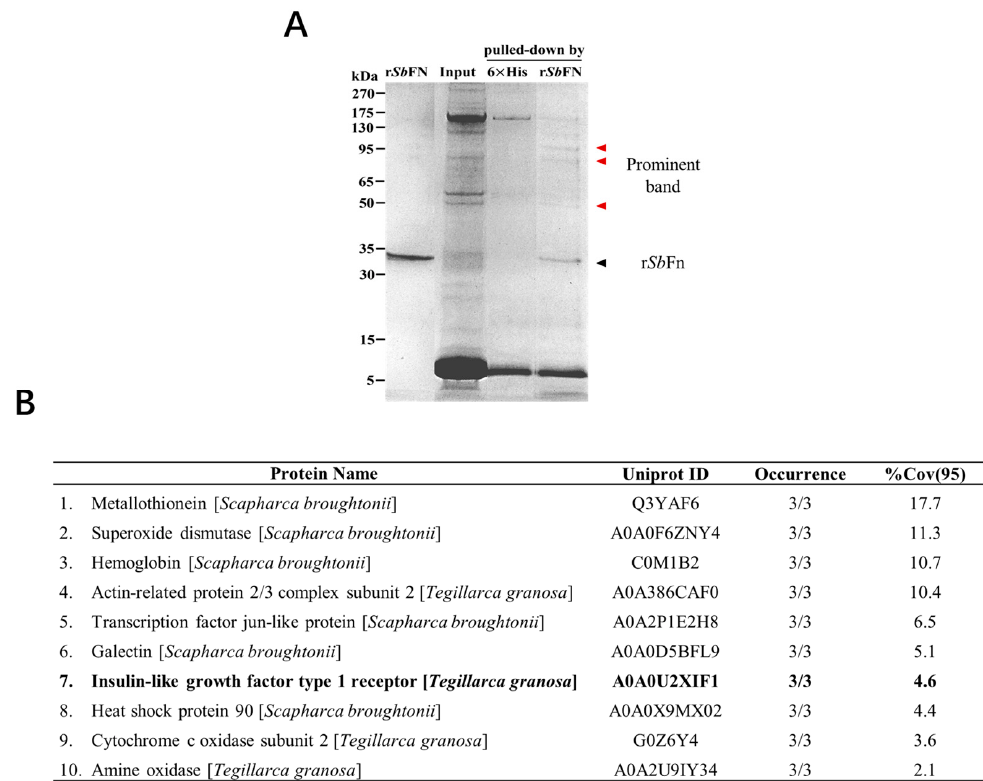
Figure 1. Identification of the Sb Fn interacting protein by His pull-down assay. ( A ) The recombinant His Sb Fn served as bait to capture the binding protein from hemocyte lysate. Hexa-His was employed as the control. The binding protein was directly analyzed by SDS-PAGE, and the different band is indicated by the arrow and characterized by LC-MS/MS. ( B ) Candidate proteins identified by LC-MS/MS interacting with Sb Fn. Occurrence refers to the times this protein was detected in three replicate experiments. %Cov (95) refers to the percentage of all identified polypeptides relative to the total amino acid sequence at 95% confidence.